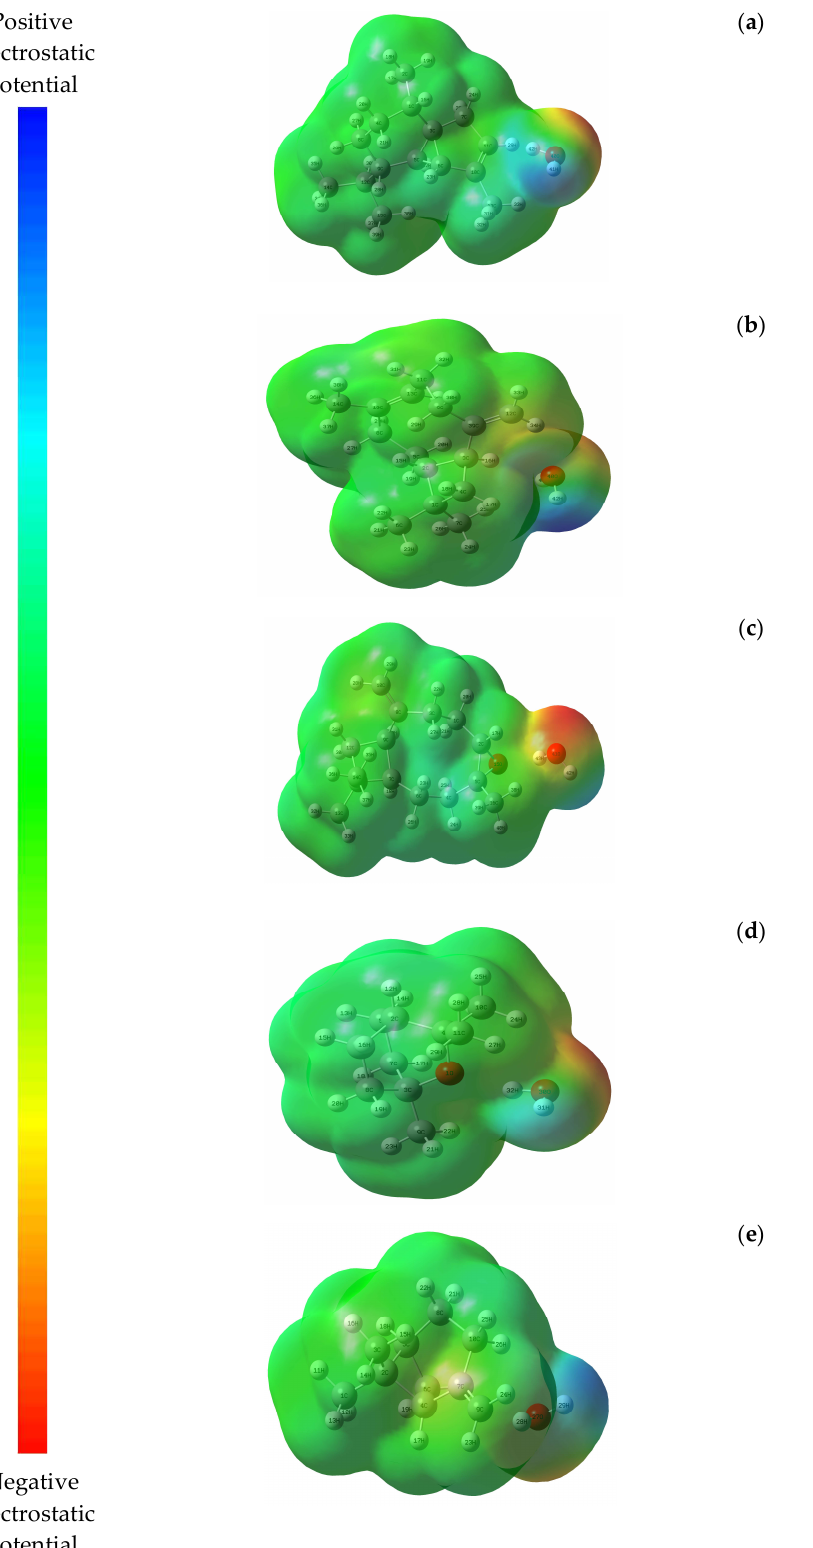
Figure 2. MEP surface maps of the binary mixtures (α-cubebene–water ( a ), β-caryophyllene–water ( b ), caryophyllene oxide–water ( c ), 1,8-cineole–water ( d ), and β-pinene–water ( e )).